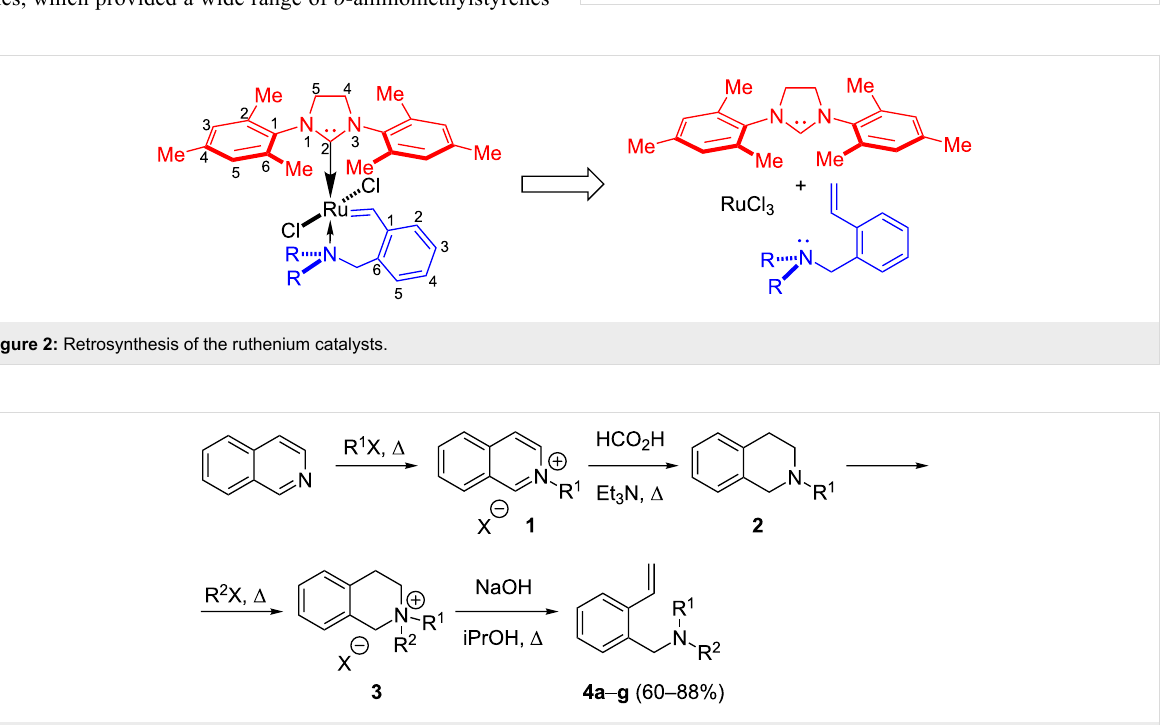
Scheme 1: Efficient multigram synthesis of N , N -dialkyl-2-vinylbenzylamines 4 (R 1 X = Me 2 SO 4 , Et 2 SO 4 or BnCl, see Experimental part, Supporting Information File 1 and Table 1).